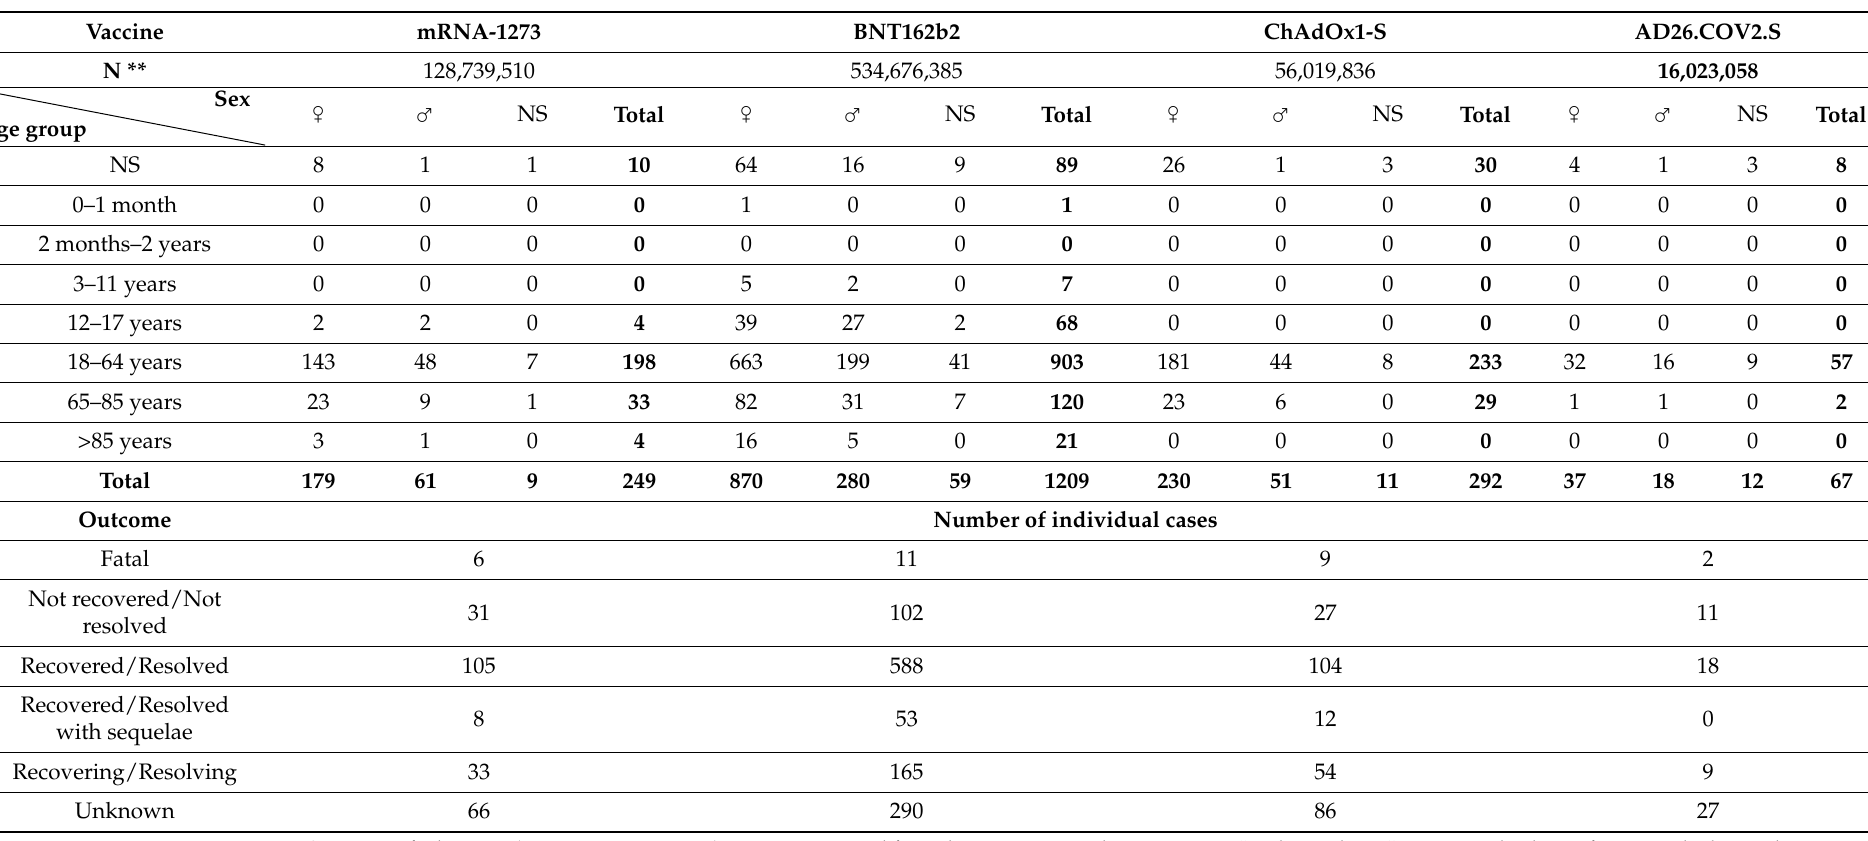
Table 2. Description of anaphylactic shock cases post-COVID-19-vaccination reported by EudraVigilance from week 52, 2020 to week 2, 2023